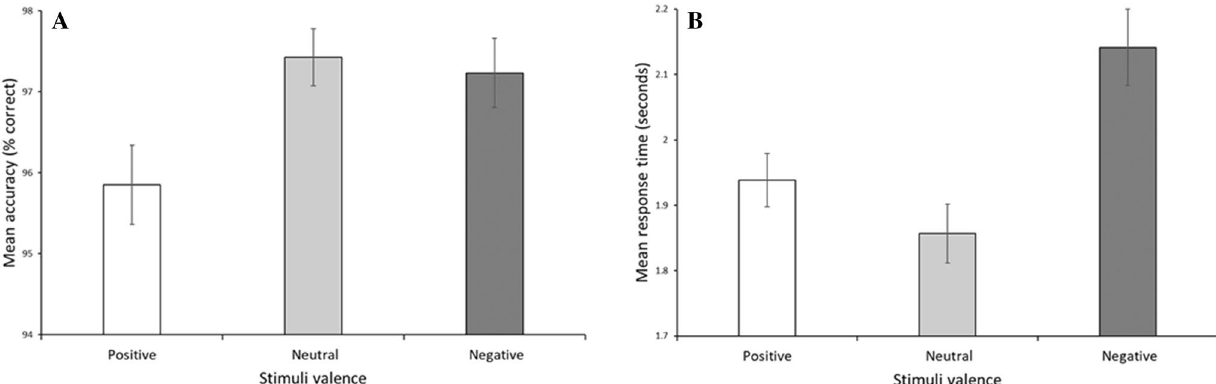
Figure 1. Mean accuracy (percentage correct) in the visual search task ( A ). Neutral trials were completed more accurately than positive trials. Error bars = standard error of the mean. Mean response time (seconds) in the visual search task ( B ). Neutral trials were completed quicker than positive and negative trials. Error bars = standard error of the